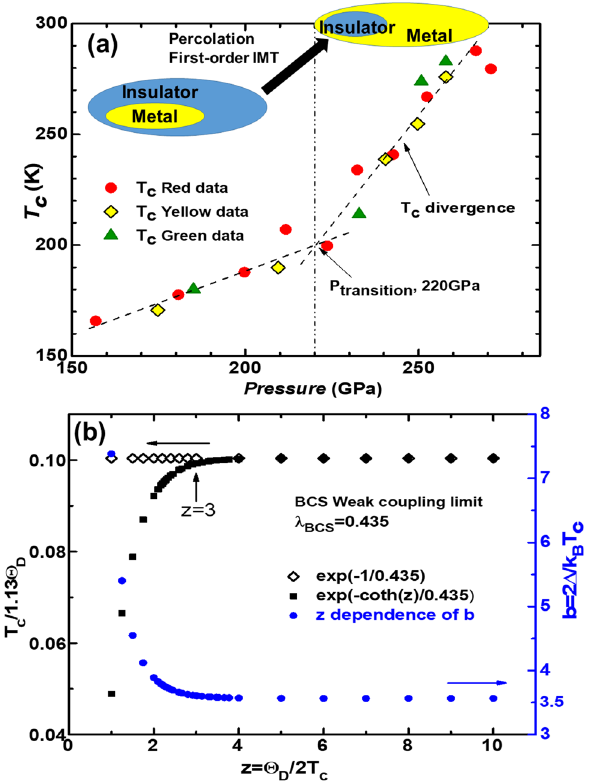
Figure 1. ( a ) Experimental data for the room-temperature T c as a function of applied pressure 8 , which shows the T c divergence over P transition = 220 GPa. The data were extracted in the paper 8 . The insulator–metal transition undergoes the first-order percolation (i.e., an increase in band filling) with increasing pressure (Inset). ( b ) A comparison of the weak coupling T c (empty diamond) and the generalized T c (filled square) in BCS theory. The coupling constant, b = 2 Δ / k B T c , (blue ball) between the generalized energy gap and the generalized T c has no restriction on the magnitude of λ BCS . The T c rapidly decreases below z = 3, which indicates that the generalized T c does not explain the high T c